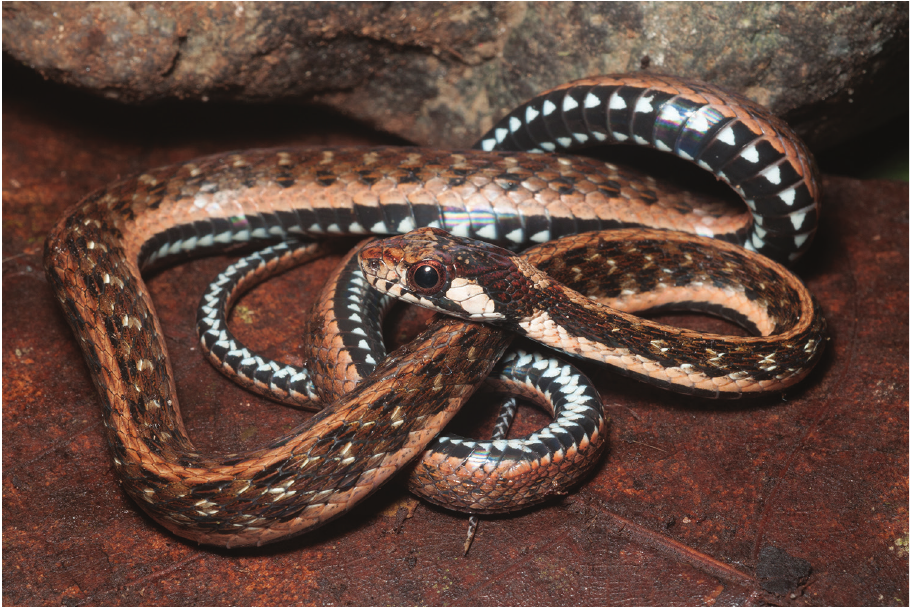
Figure 72. Rhabdophis auriculata auriculata (KU 334441) from Eye Falls, Mt. Hilong-hilong, Munici- pality of Remedios T. Romualdez, Agusan del Norte Province. Photo: